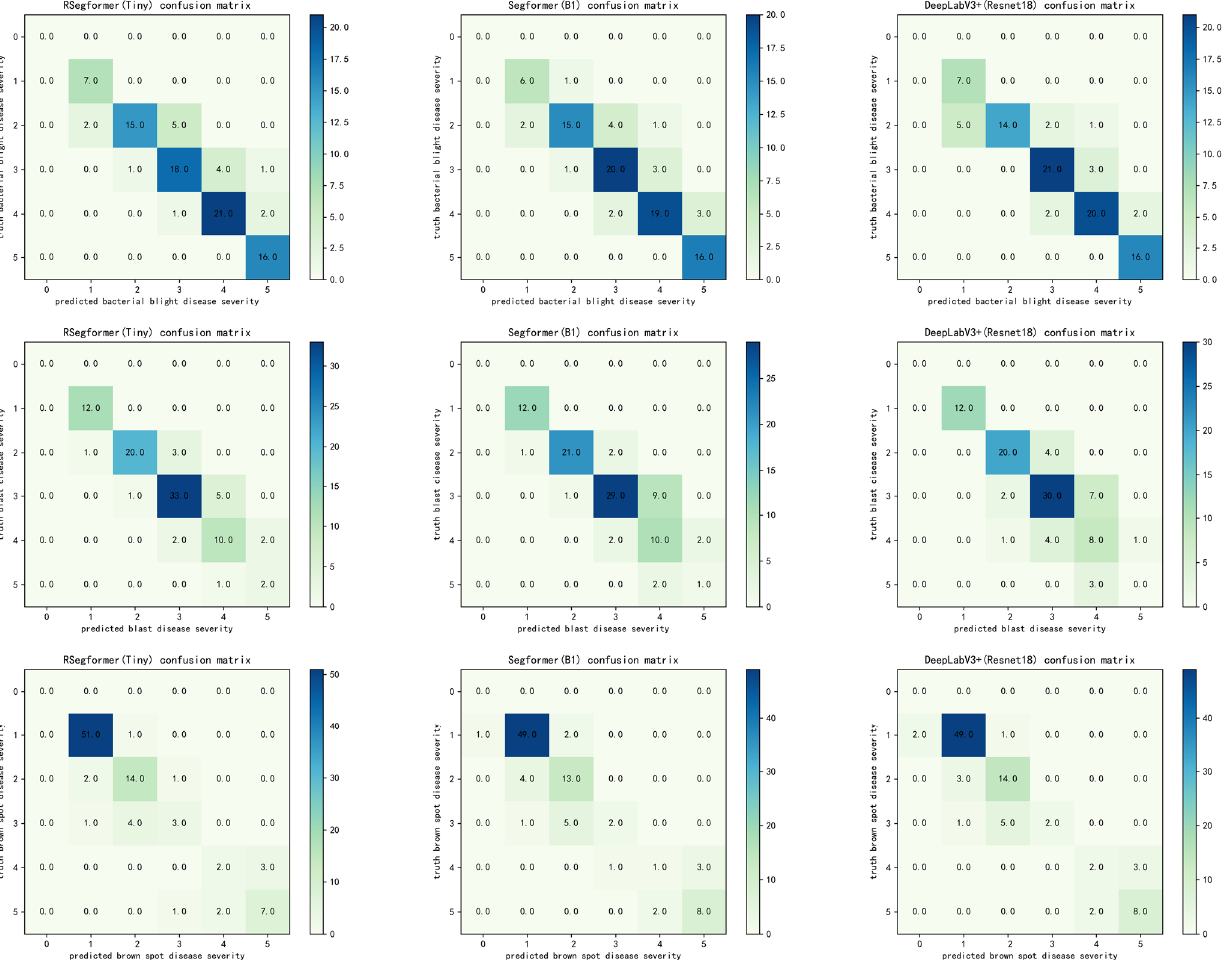
Figure 9. Confusion matrices for the severity classes of different rice diseases under different network models. The first row is the confusion matrix of the three models for the estimation of the severity of rice bacterial blight disease, the second row is the confusion matrix of the three models for the estimation of the severity of rice blast disease and the third row is the confusion matrix of the three models for the estimation of the severity of brown spot disease.